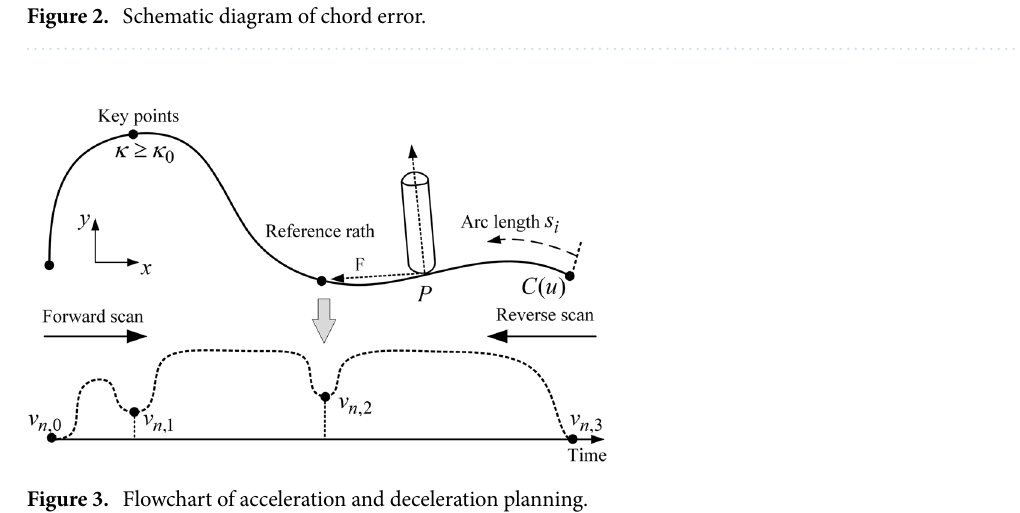
Figure 3. Flowchart of acceleration and deceleration